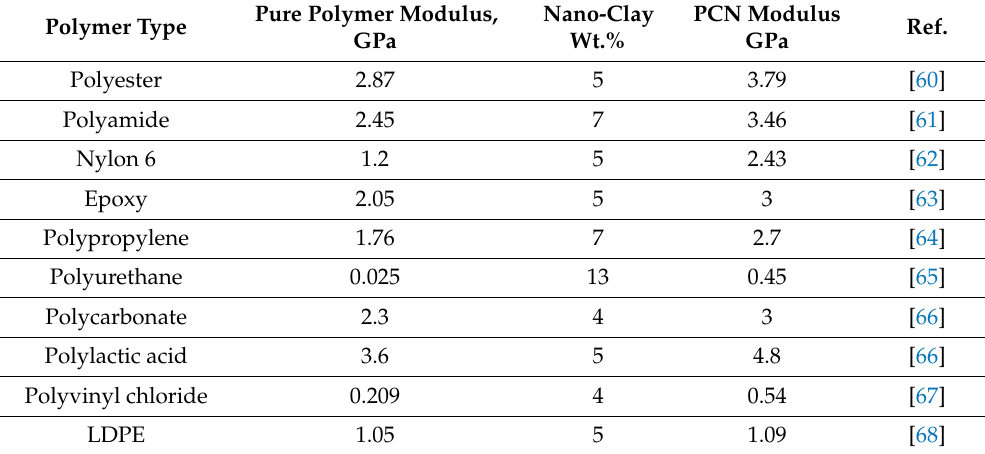
Table 1. Young’s modulus for different polymer–clay